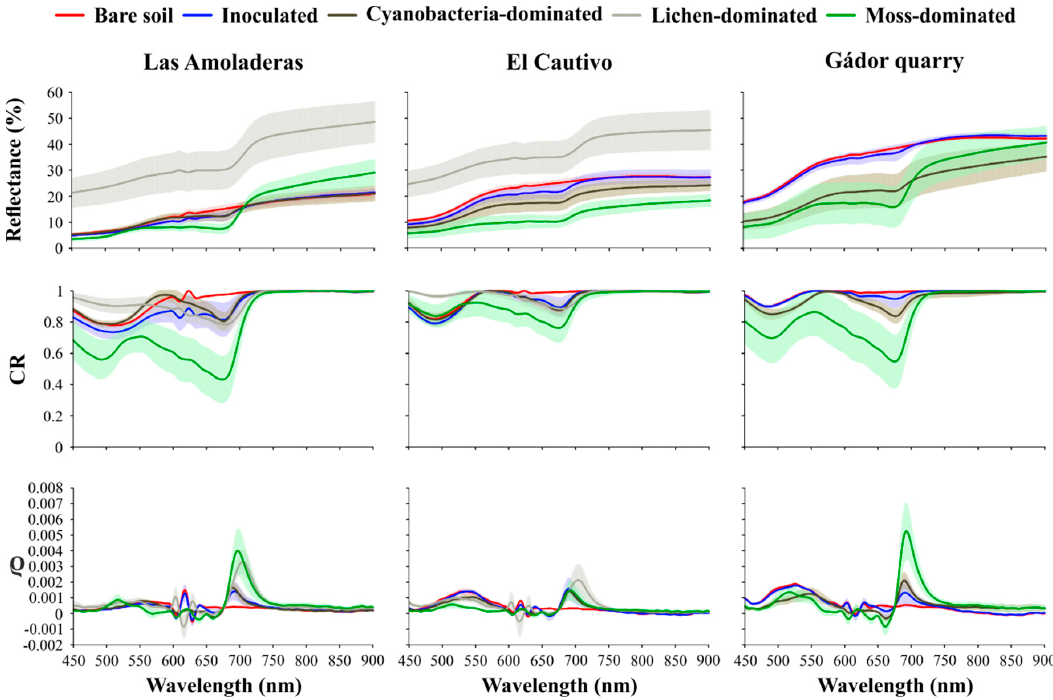
Figure 3. Mean (± SD represented as the shaded area) of the hyperspectral reflectance (R), continuum removal (CR), and first derivate of reflectance ( ρ ) of different natural biocrust types, as well as artificial biocrust (inoculated) and non-inoculated control plots samples (bare soil), in Las Amoladeras, El Cautivo, and Gádor quarry study sites.